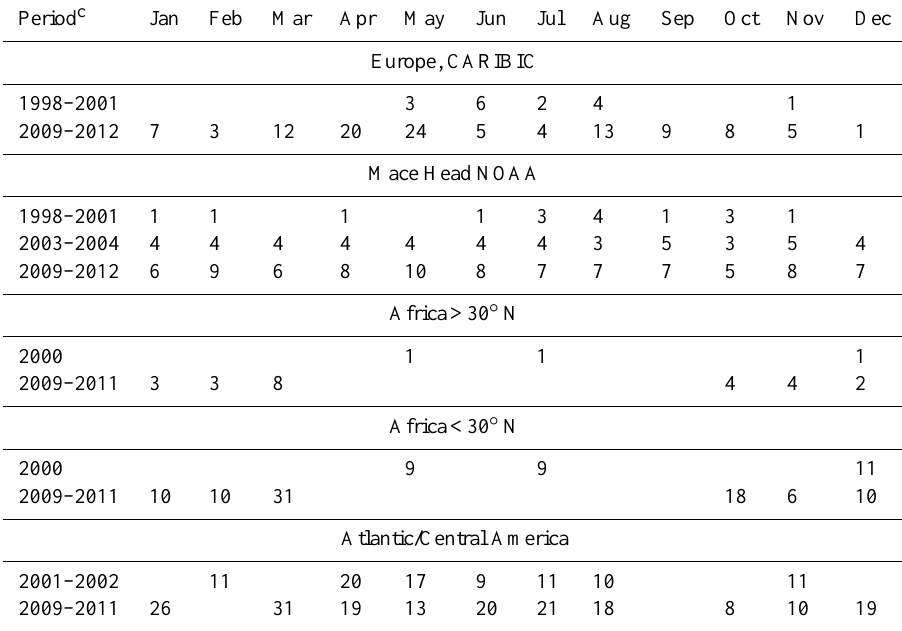
Table 3. Seasonality of available CARIBIC data for regions included in this study. a Black squares show that samples were taken during that month and the number refers to the number of samples. b